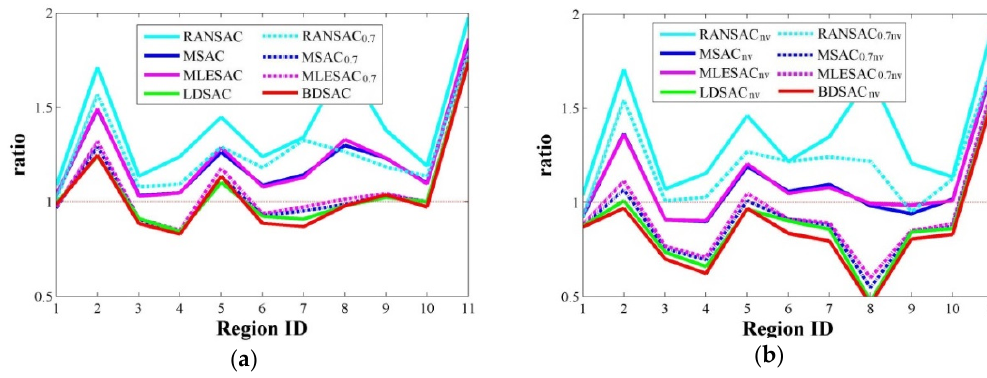
Figure 9. Suppressing ratios comparison. The spurious planes detected by RANSAC in Figure 8 (regions 1–11). ( a ) Suppressing ratio for methods that only consider point-plane in weight functions; ( b ) Ratios for methods considering both distance and angular difference.